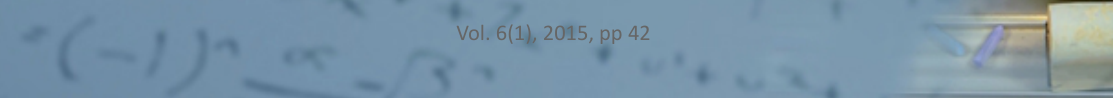
Description: (Figure 1) The applet simulates the one-dimensional motion of a car with adjustable values for initial position, initial velocity, and